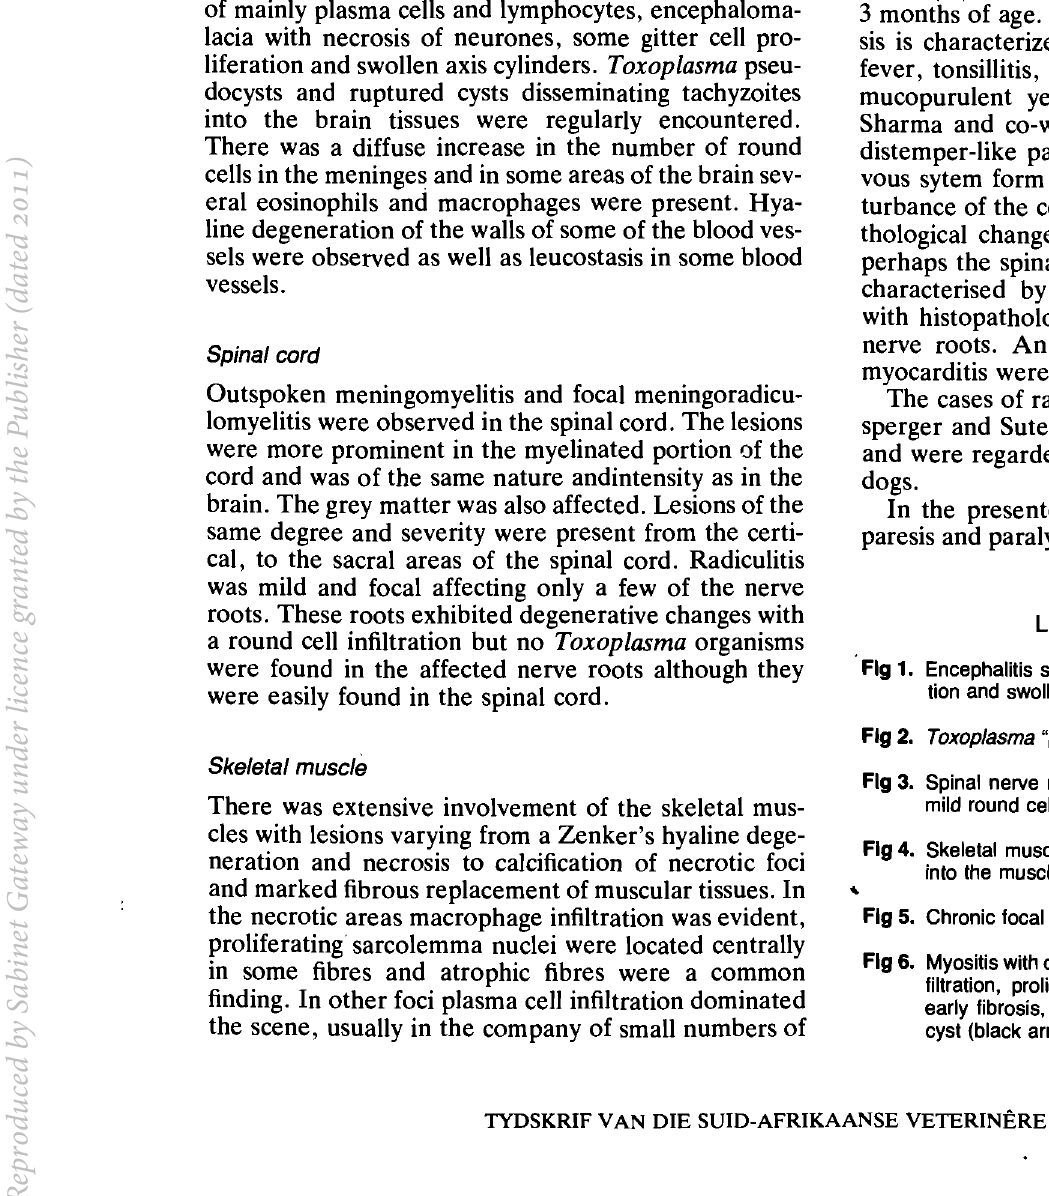
TYDSKRIF VAN DIE SUID-AFRIKAANSE VETERINERE